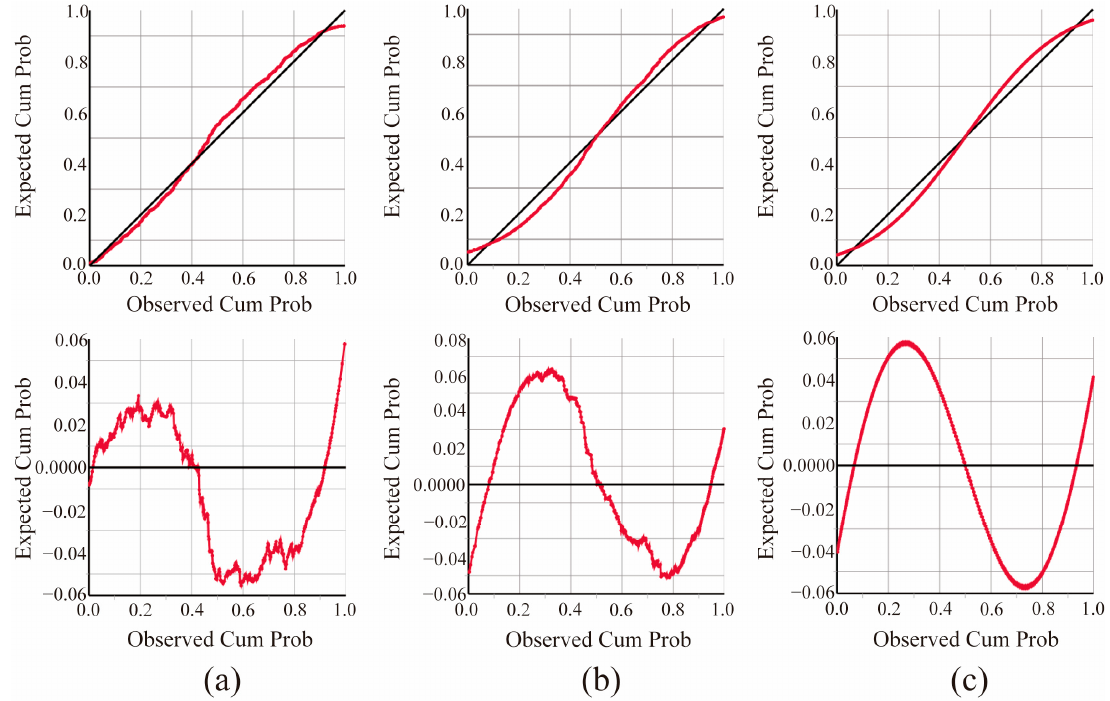
Figure 9. Normal and detrended normal P − P plot: ( a ) urban hierarchy of public libraries; ( b ) spatial hierarchy of public libraries considering the subway routes; and ( c ) degree of utilization activation. Table 4. Descriptive statistics.